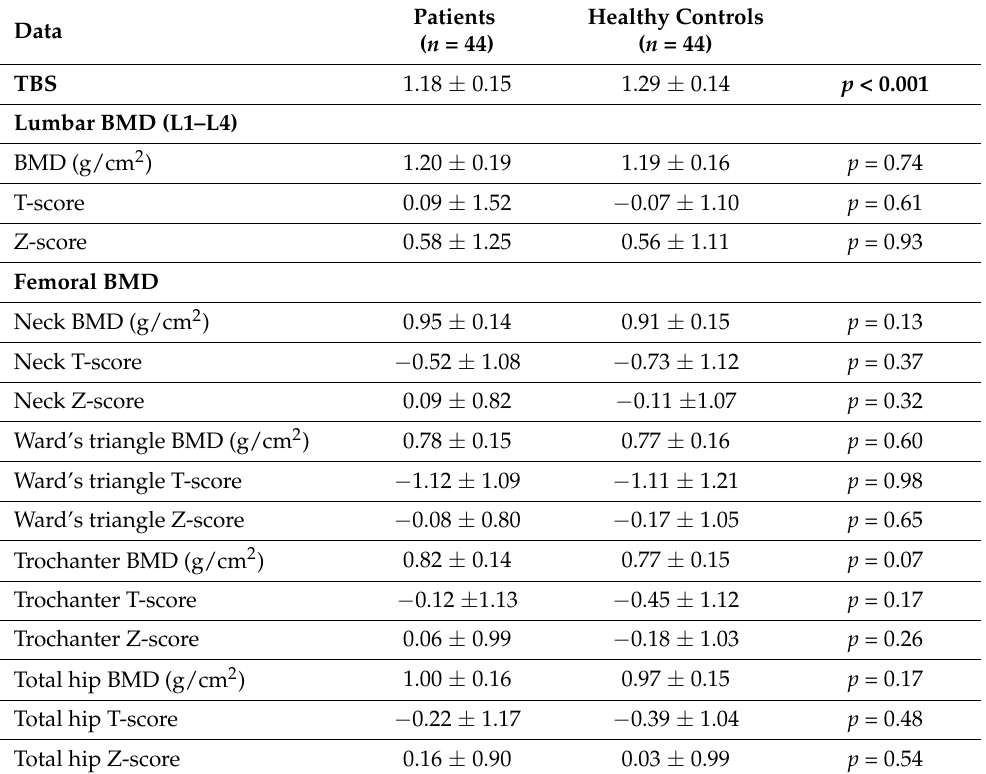
Table 3. Mean TBS (lumbar), BMD, T-score, and Z-score (all sites) in acromegalic patients and matched healthy controls.